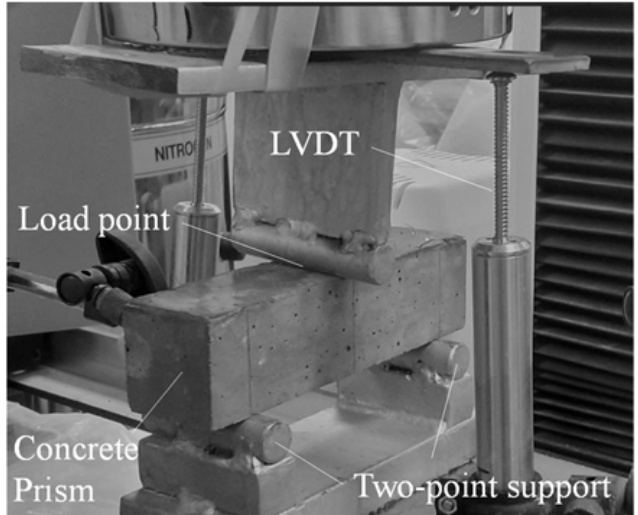
Figure 4. Flexural test setup.